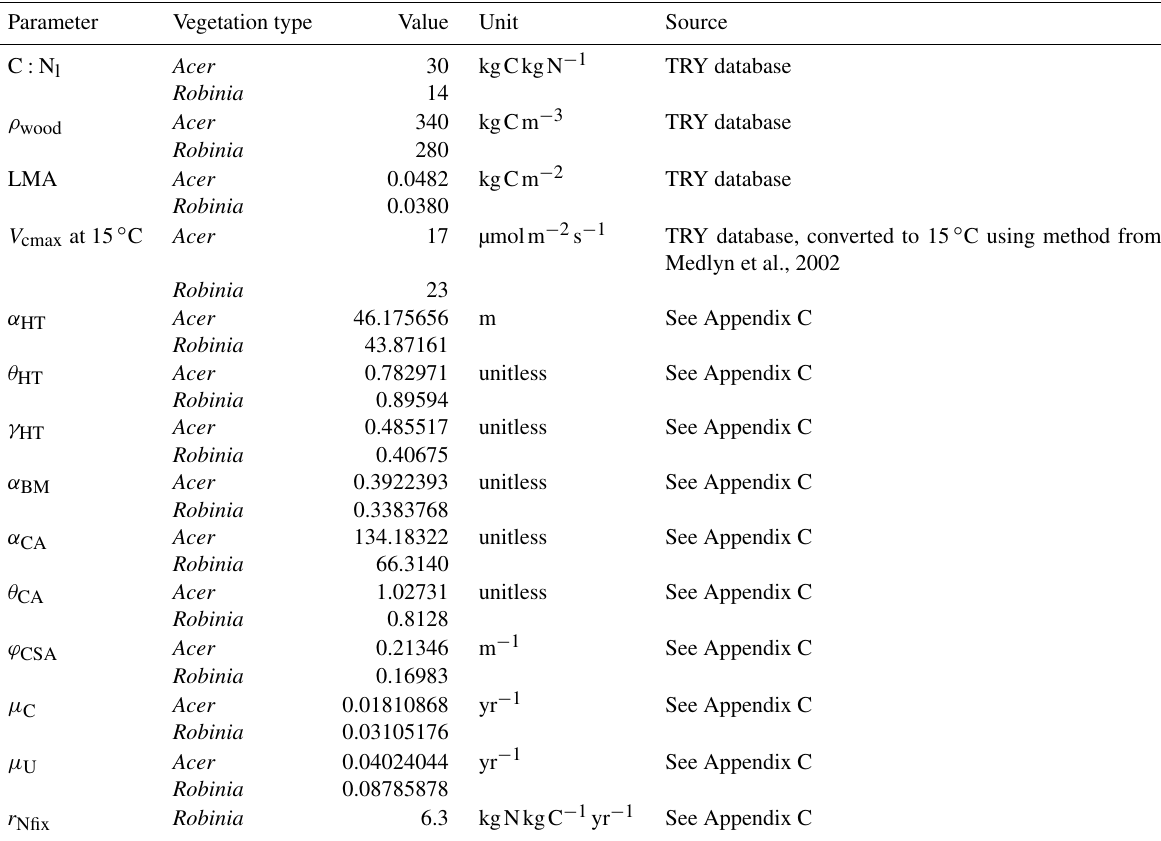
Table D1. Vegetation-type-specific parameters.